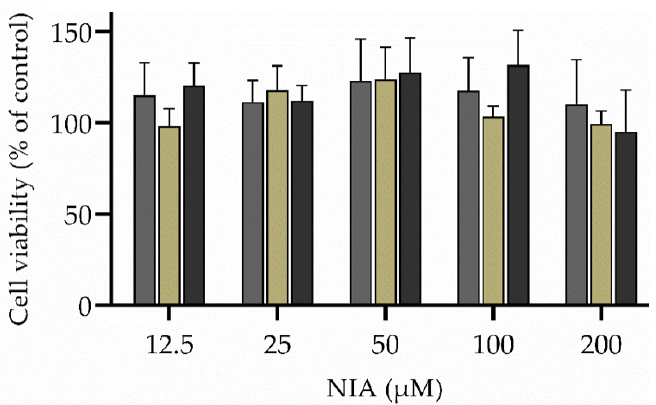
Figure 5. Effects NIA on cell viability in HaCaT keratinocytes. Free NIA (grey bar), NIA-loaded hydrogel (dark yellow), and NIA-loaded nanogel (dark grey) on cell viability in HaCaT keratinocytes. Each value represents the mean ± SD ( n ≥ 3). No asterisks indicate no statistical significance ( p > 0.05).